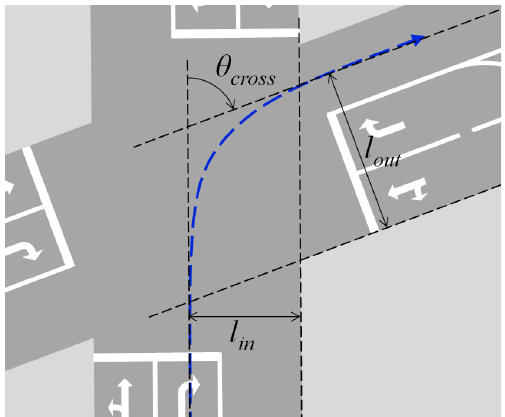
Figure 9. Definitions of intersection shape related